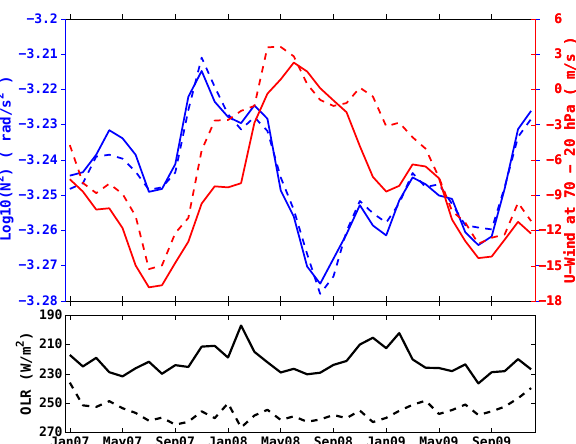
Figure 5. Time variations in N 2 (blue line) and U (red line) with positive eastward propagation in the tropics in the 20–27km height range (top panel) and OLR (bottom). Solid and dashed lines corre- spond to the longitude regions (a) 90–150 ◦ E and (b) 170–230 ◦ E, respectively.